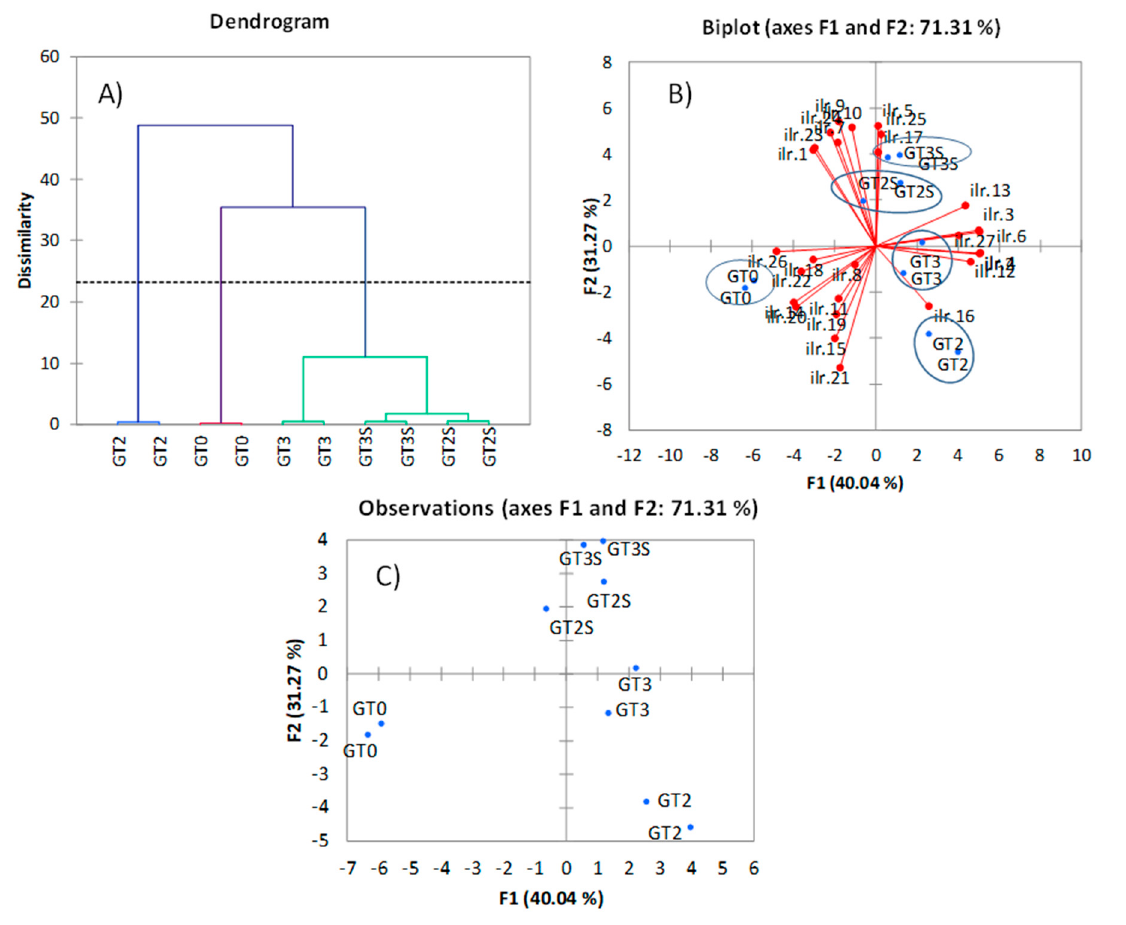
Figure 3. Cluster ( A ) and PCA ( B , C ) based on ilr coordinates of the overall original minor components’ data in green Spanish-style Gordal table olive fat: GT0, GT2 and GT3 are oils extracted from the fresh, fermented and packaged olives, respectively. Samples coded S were extracted by Soxhlet; otherwise, they were extracted by Abencor. ilr 1–25 stand for the successive coordinates obtained by isometric logratio transformation.